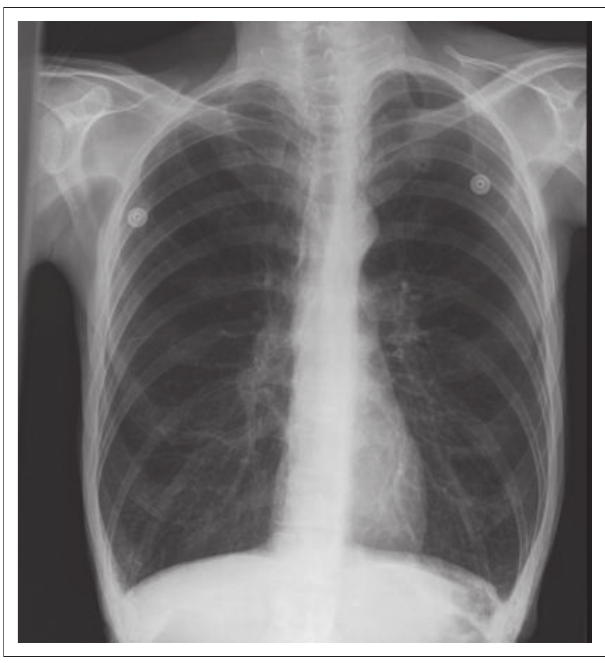
FIGURE 3: Chest X-ray for objectively structured clinical examination station (main finding: only